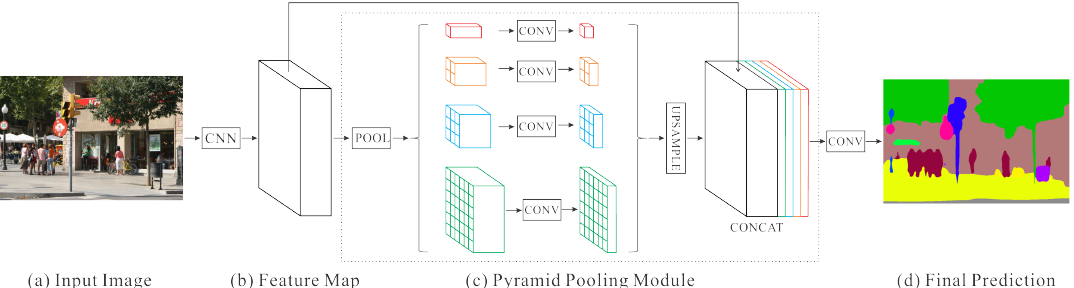
Figure 6. The PSPNet architecture (Figure reproduced here with kind permission from the